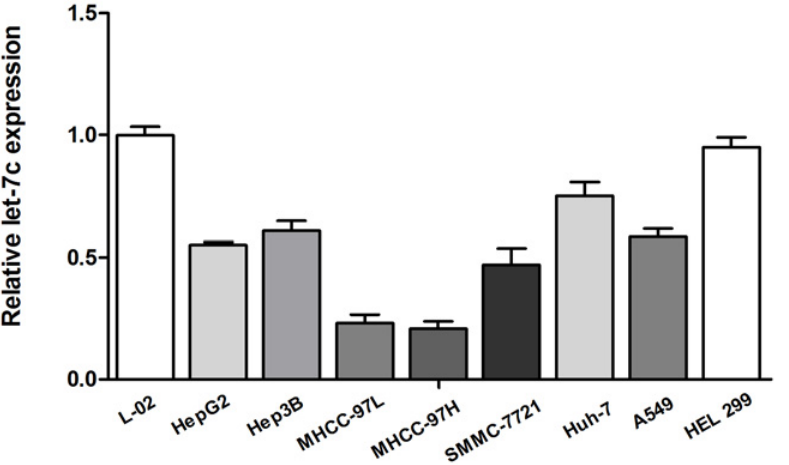
Fig 1. Let-7c is down-regulated in various HCC cell lines. Let-7c expression levels in various HCC cell lines (HepG2, Hep3B, SMMC-7721,Huh-7, MHCC97-H, and MHCC97-L), the normal human liver cell line L- 02, A549 lung cancer cells and HEL 299 cells (human embryonic lung cell) were determined by quantitative real-time PCR. Each sample was analyzed in triplicate and normalized to U6 expression.